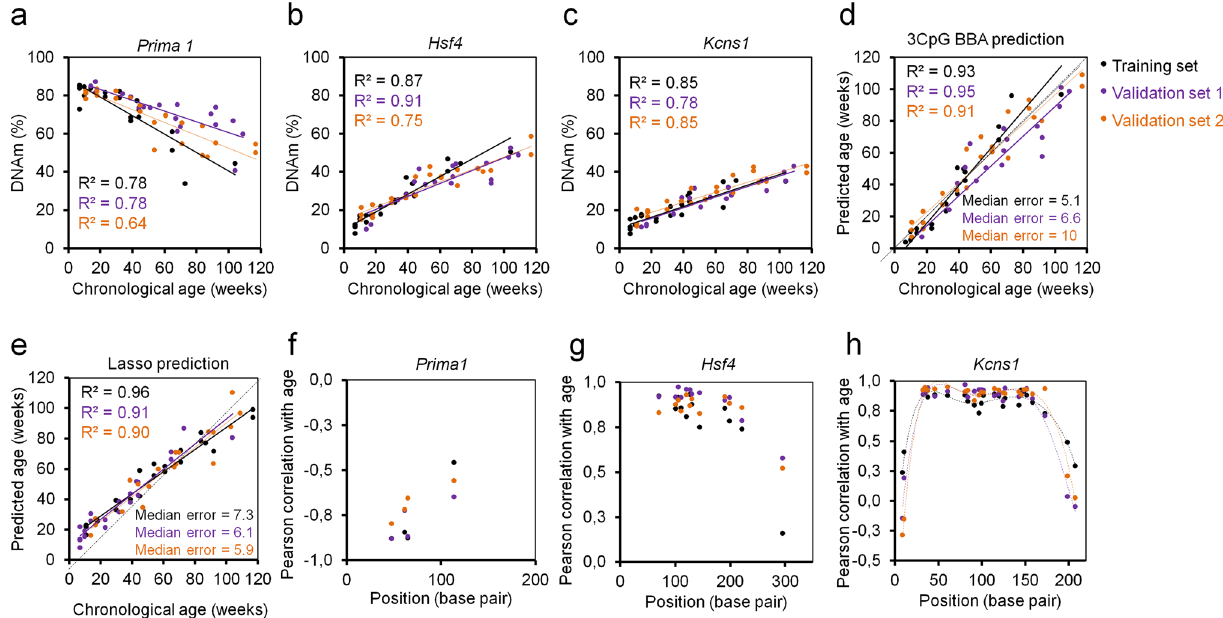
Figure 3. Epigenetic age-prediction by BBA-seq. DNAm levels (%) of three highly age-associated CpGs within three amplicons Prima1 ( a ), Hsf4 ( b ) and Kcns1 ( c ) were determined by barcoded bisulfite amplicon sequencing (BBA-seq). ( d ) Age predictions based on the multivariable linear regression model of three CpGs in the C57BL/6 mice. (e ) Age predictions with a lasso regression model (7 CpGs in the three age-associated regions), which was trained on the training set of C57BL/6 mice. Coefficients of determination (R 2 ) of DNAm versus chronological age and median errors (weeks) are indicated. ( f–h ) Pearson’s correlations of age with DNAm levels of CpGs within the amplicons of Prima1 , Hsf4 , and Kcns1 are plotted for the blood samples of the training set (n = 23) and two independent validation sets (n = 21 and 19). The x-axis represents the position of CpGs within the